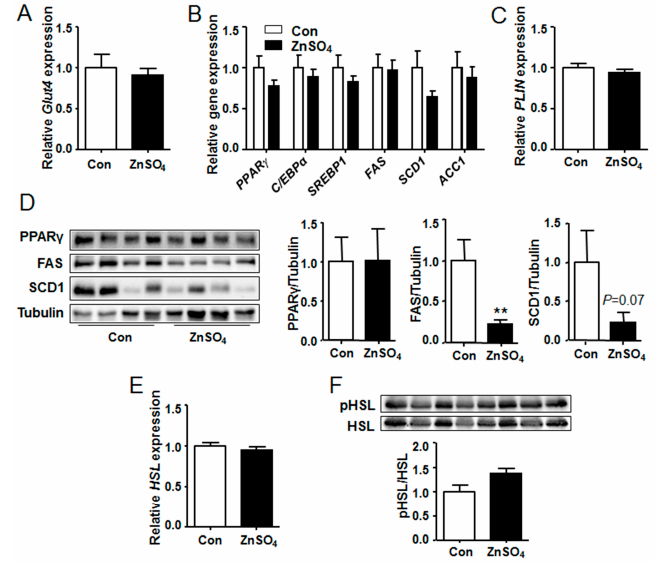
Figure 6. Chronic zinc supplementation did not alter the expression of lipogenic genes but decreased protein levels of FAS and SCD1 in perirenal adipose tissue. ( A ) The expression of Glut4 ; ( B ) The expression of lipogenic genes and their regulatory genes; ( C ) The expression of PLIN ; ( D ) Protein levels of PPAR γ , FAS and SCD1 ( P = 0.0006 for FAS); ( E ) The expression of HSL ; ( F ) Phosphorylation levels of HSL. N = 8 for each group. Data were shown as mean ± SEM. Western blots represented 8 mice of 16 in total. Con, control group; ZnSO 4 , zinc sulfate-supplemented group. ** P < 0.01 ZnSO 4 vs. Con.